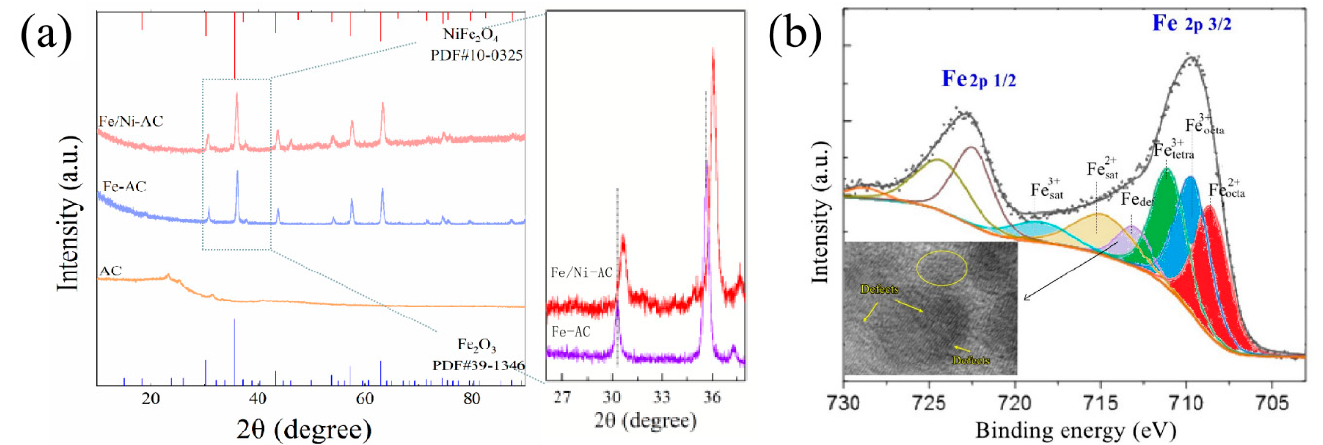
Figure 4. ( a ) XRD patterns of as-prepared AC, Fe-AC, and Fe/Ni-AC (inset: the enlarged parts in the 2 θ range from 26° to 38°); ( b ) Fe 2p spectra profiles of Fe-AC.